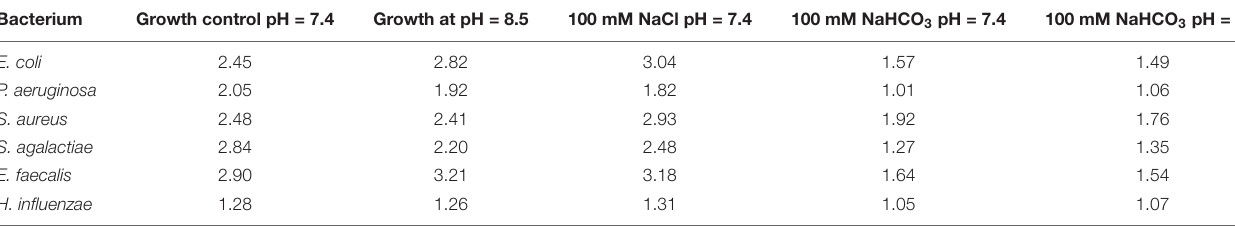
TABLE 1 | Calculated AUC values of different bacteria, based on growth curves in Figures 1A–F . Bacterium Growth control pH = 7.4 Growth at pH =